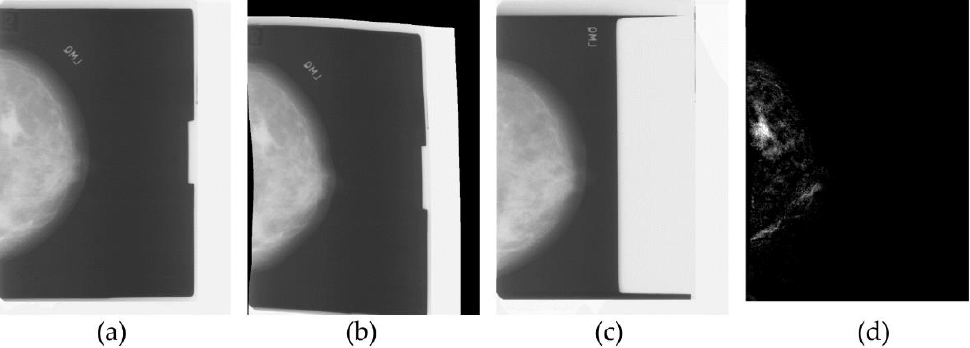
Figure 1. Traditional medical image processing on temporal mammograms. From left to right: the most recent mammogram ( a ) is registered to the previous mammogram ( b ), which is shown in ( c ). After registration there is one predominant region of significant difference in the subtraction image ( d ), which corresponds to a mass developed in the breast.